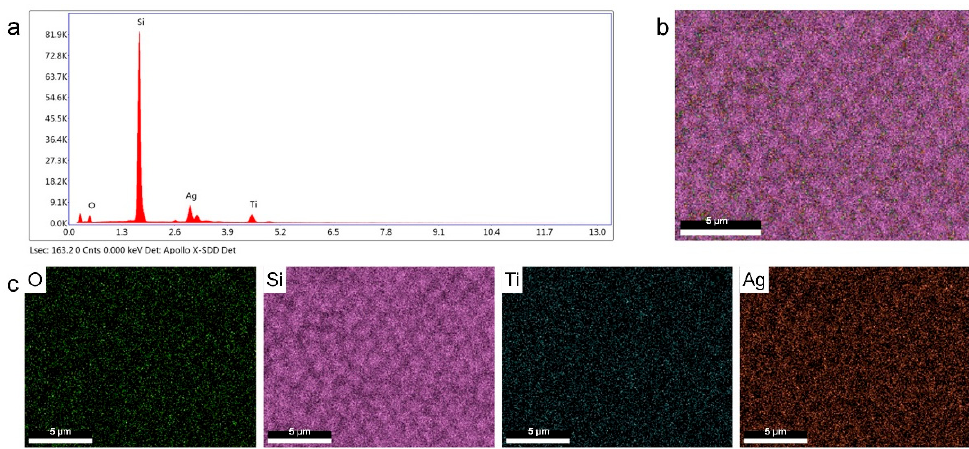
Figure 2. ( a ) EDS spectrum of Ag/3D-TiO 2 /Si; ( b ) EDS element mapping image of Ag/3D-TiO 2 /Si; ( c ) EDS mapping images of elements O, Si, Ti, and Ag.